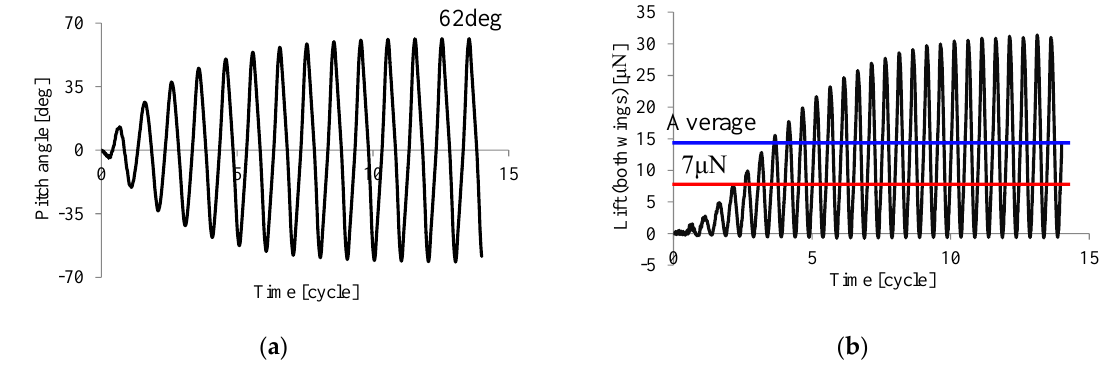
Figure 14. Time histories of ( a ) the tip displacement (solid line) and the base displacement (dotted line) in the x -direction and ( b ) the flapping angular displacement.